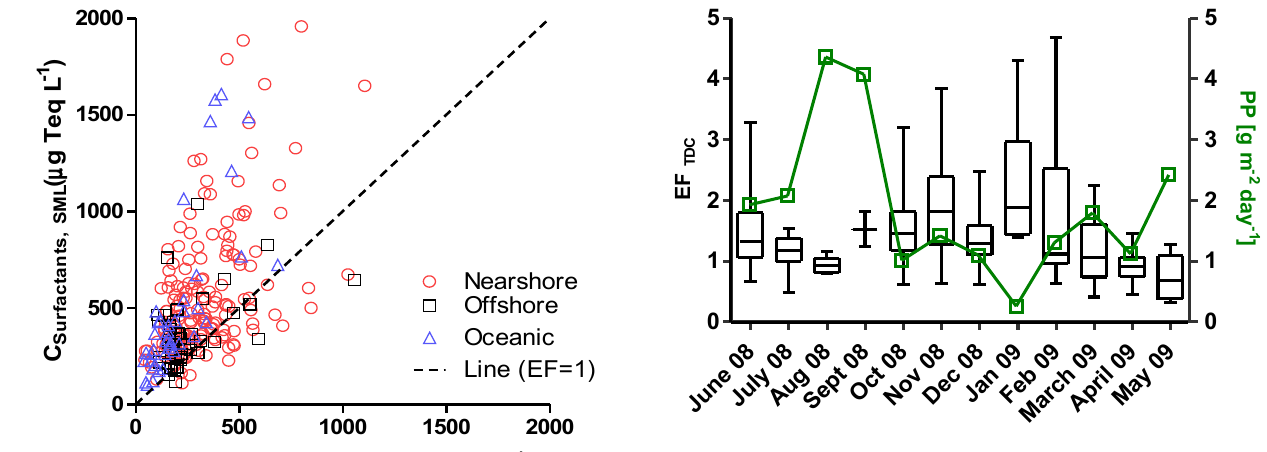
Fig. 6. Seasonal time series of the monthly average enrichment fac- tors (EF) of total dissolved carbohydrates in Saanich Inlet. Monthly averaged primary production (PP) is represented by (cid:3) symbols.